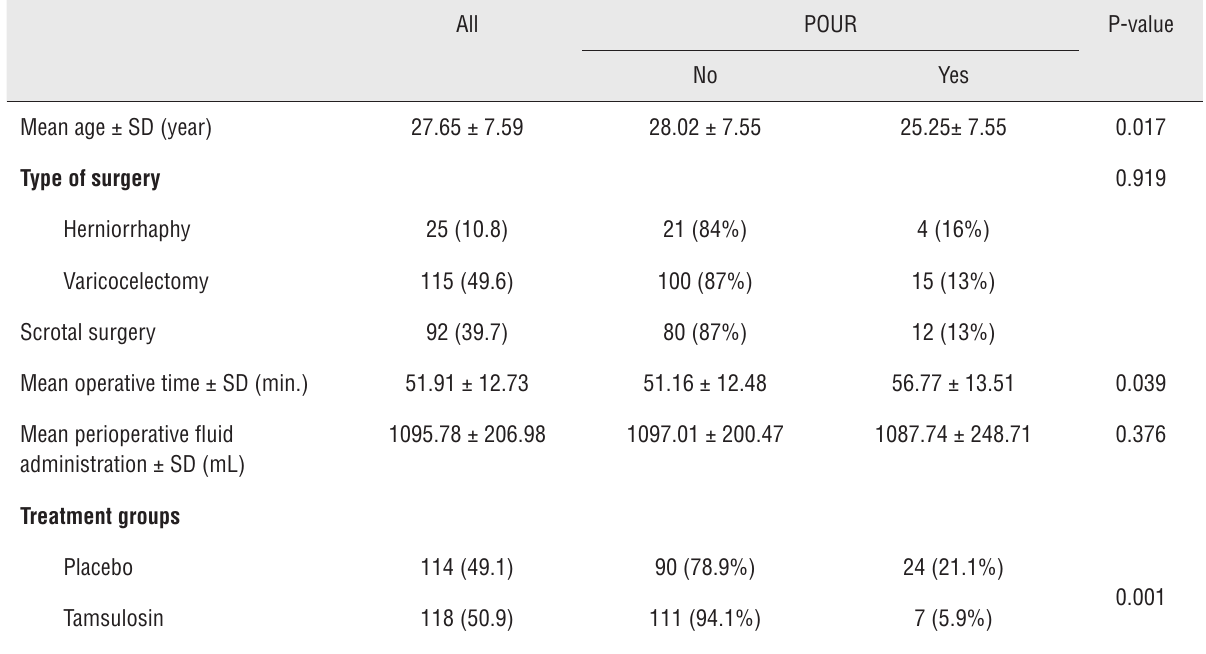
Table 2 - Associated factors of POUR within 24 hours after surgical intervention. Mean age ± SD (year)